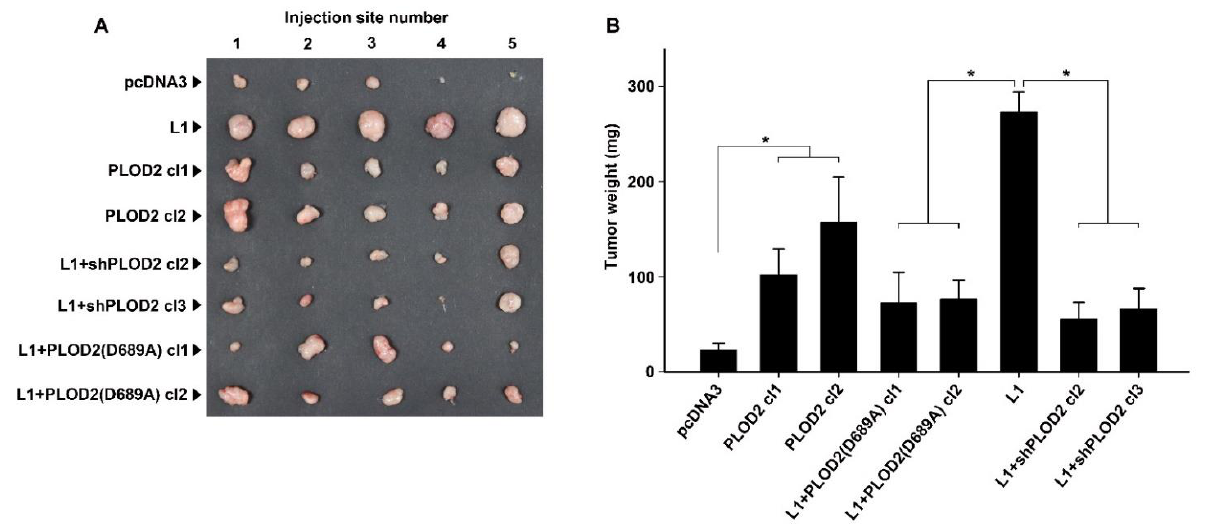
Figure 3. The L1-mediated increase in CRC cell proliferation in vivo requires PLOD2. ( A ) The cell clones described in Figure 2A were injected s.c. into immunocompromised nude mice and the tumors that developed were excised after eleven days. ( B ) Tumor weight was determined for the different CRC cell clones that were injected. Note the increase in tumor formation with L1-expressing (compare L1 to pcDNA3) and PLOD2-expressing cells (compare PLOD2 to pcDNA3) and the decrease in tumor development with cells expressing L1+ PLOD2 (D689A) and L1 + shPLOD2. * p < 0.05.